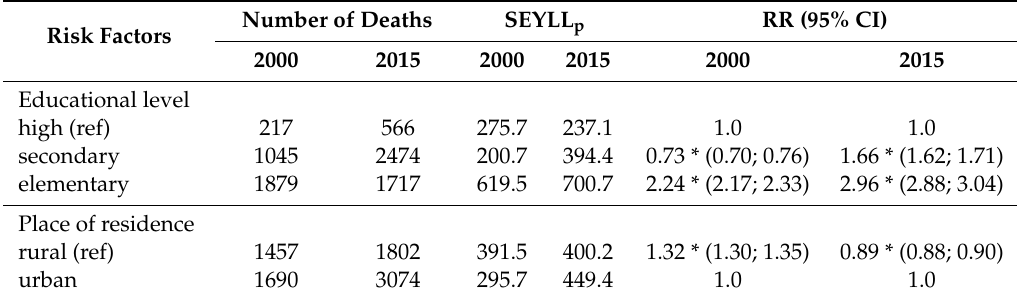
Table 3. Standard expected years of life lost (SEYLL p ) due to prostate cancer and rate ratio (RR) by level of education and place of residence, 2000 and 2015, Poland.